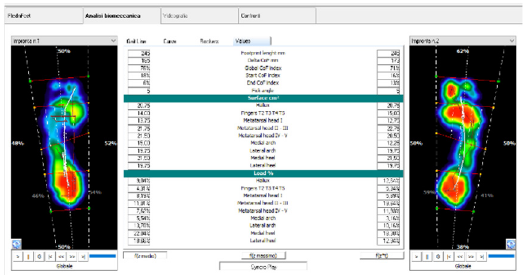
Figure 3. Software workflow.